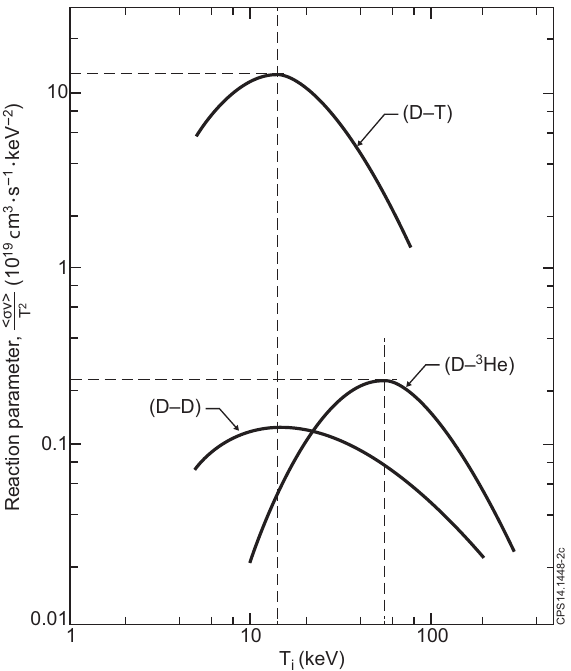
Fig. 5. – Maxwellian averaged values for (cid:2) σv (cid:3)